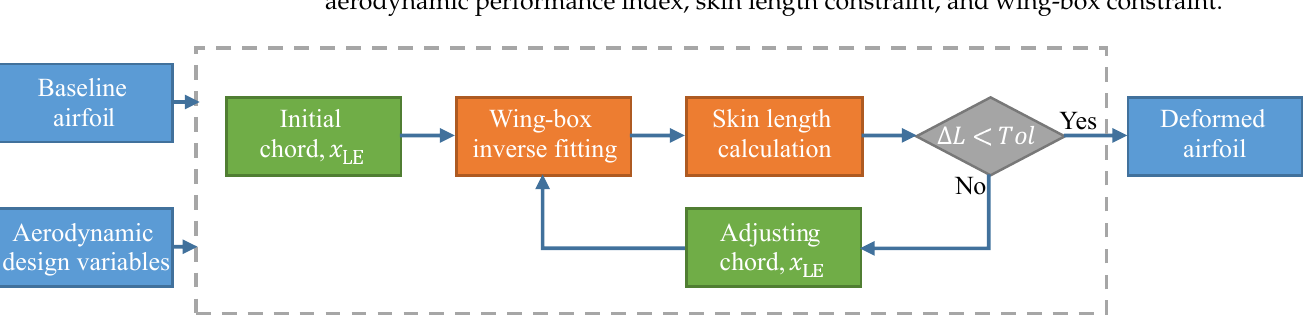
Figure 3. Morphing algorithm for maintaining the wing-box and the length of the